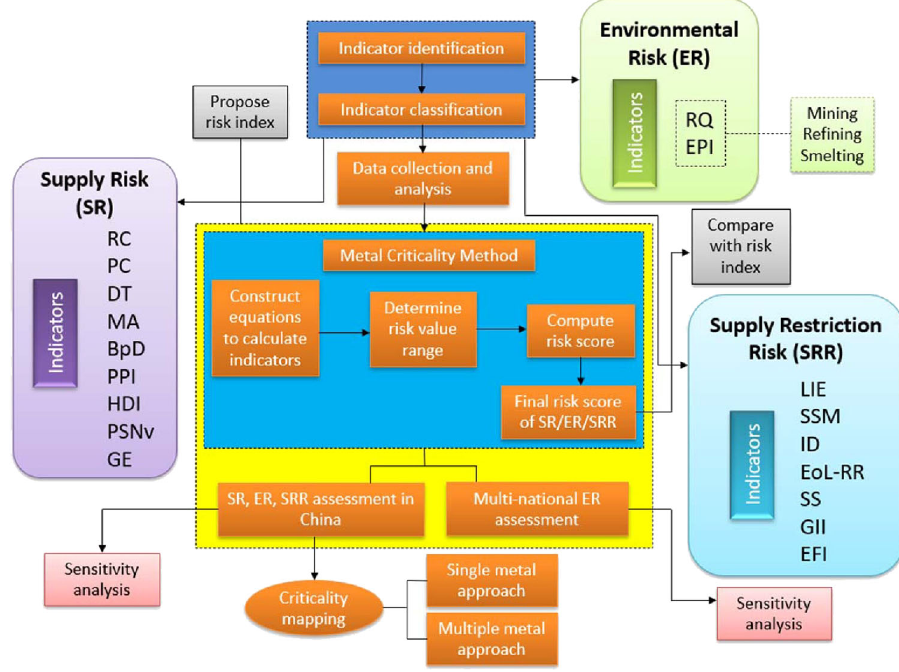
Fig. 1 An overall illustration of the research framework. The detailed fl ow shows steps beyond the criticality method development.